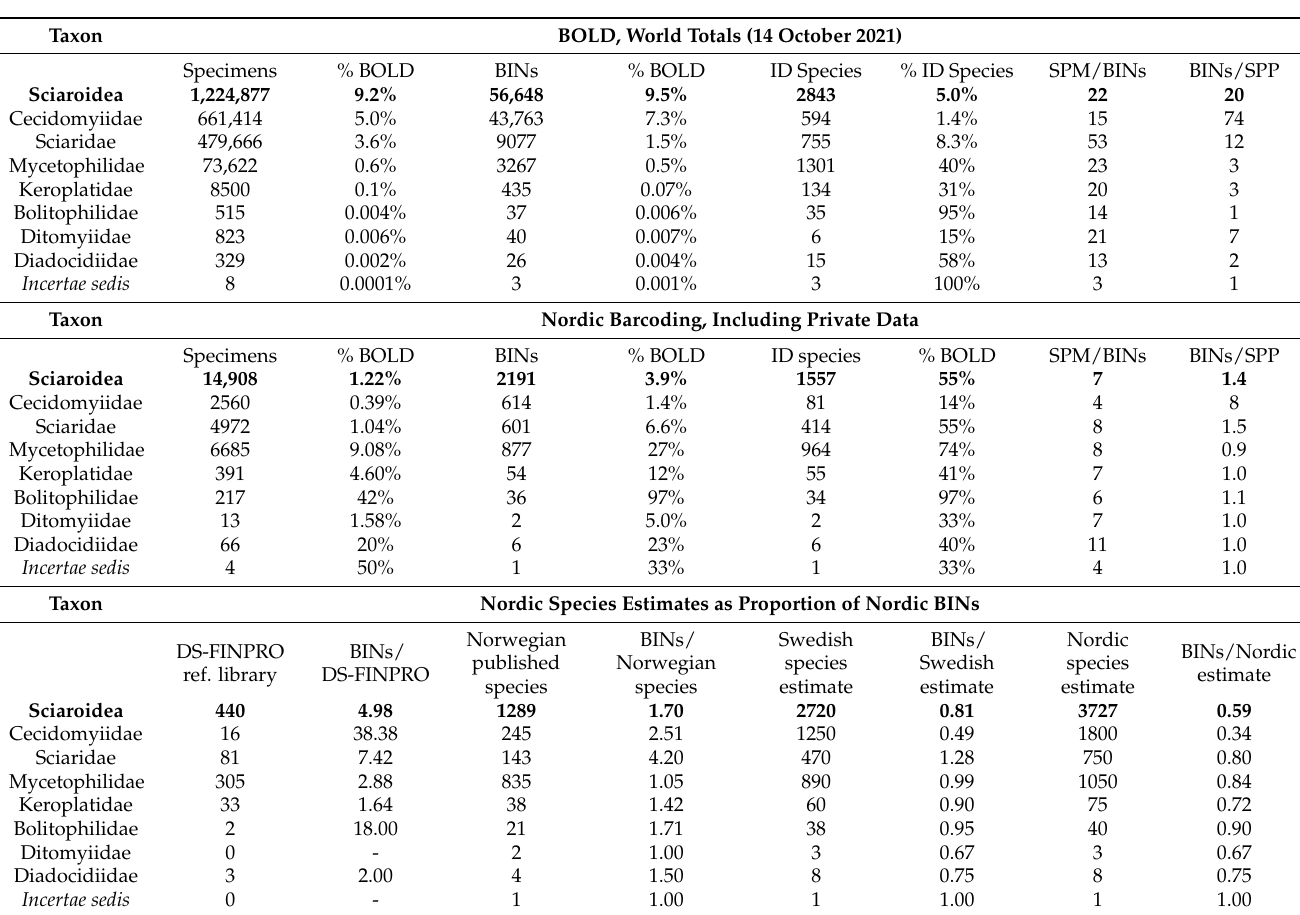
Table 1. Statistics of DNA barcoded Diptera belonging to superfamily Sciaroidea extracted familywise from BOLD as of 14 October 2021. DS-FINPRO is a published dataset on BOLD serving as a Finnish reference library presented by Roslin et al. [26]. Norwegian published species are extracted from Elven and Søli [27] with additions on the Mycetophilidae by Kjærandsen and Søli [24] and some new data extracted from GBIF. The Swedish estimate is taken from Ronquist et al. [4]. The Nordic estimate is original, including unpublished data in progress of being published, with an estimate for the Cecidomyiidae kindly mediated by M. Jaschhof ( pers. com. ). Abbreviations: BINs = Barcode Index Numbers, BOLD = Barcode of Life online database BoldSystems, ID species = morphologically identified species, SPM = specimens, SPP =